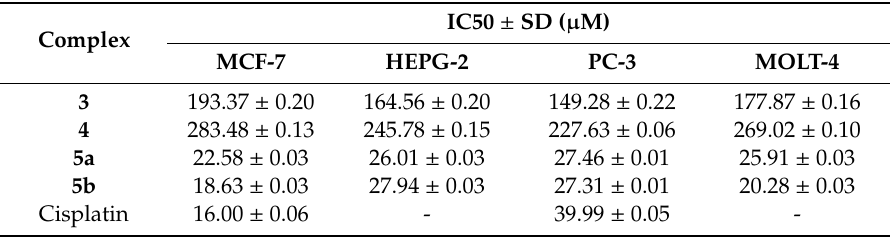
Table 3. Anticancer activities of selected compounds in DMSO